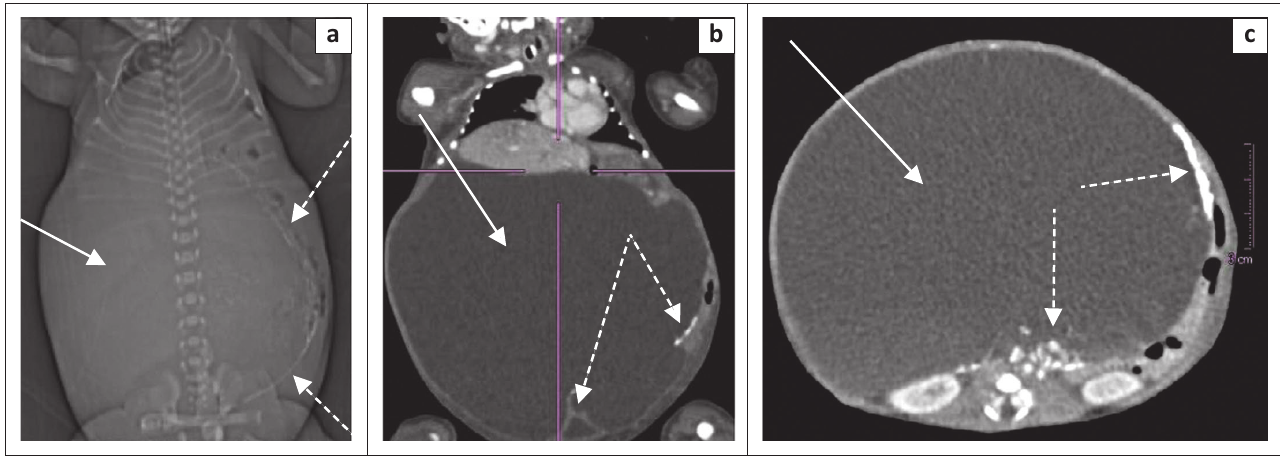
FIGURE 2: Topogram (a), coronal (b) and transverse (c) CT images of the abdomen on the day of birth revealed a large, cystic intra-abdominal mass (white arrows) with calcified rim (dashed arrows) displacing the internal organs, which radiologically confirmed the diagnosis of a meconium pseudocyst. The neonate tested positive for CMV infection at